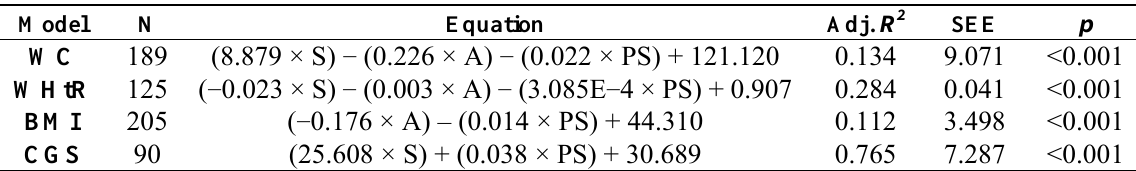
Table 6. Unhealthy participant data. Significant ( p < 0.05) regression models combining sex (S: 0 = female, 1 = male), age (A; year), and PASE score (PS) to predict WC (cm), WHtR, BMI (kg/m2), and CGS (kg).